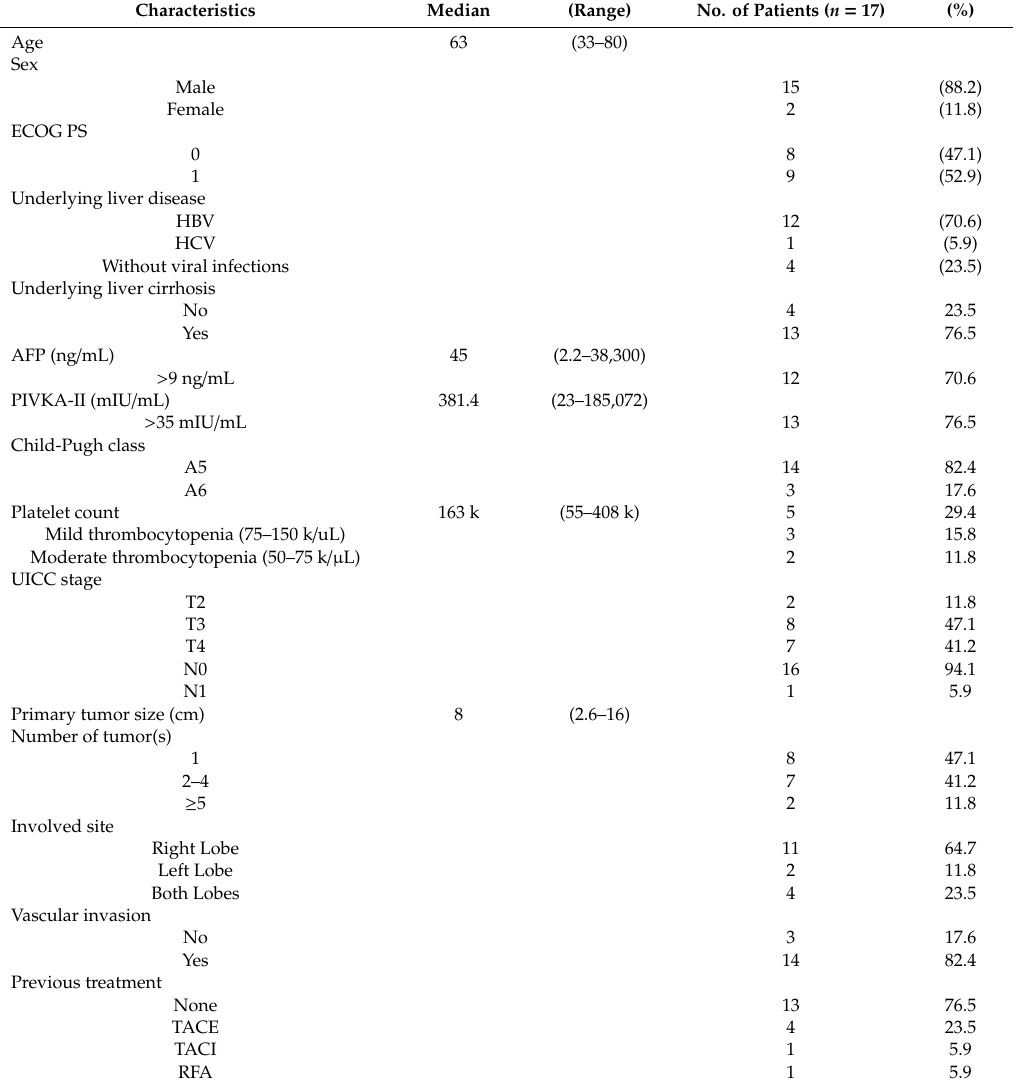
Table 1. Patients and tumor